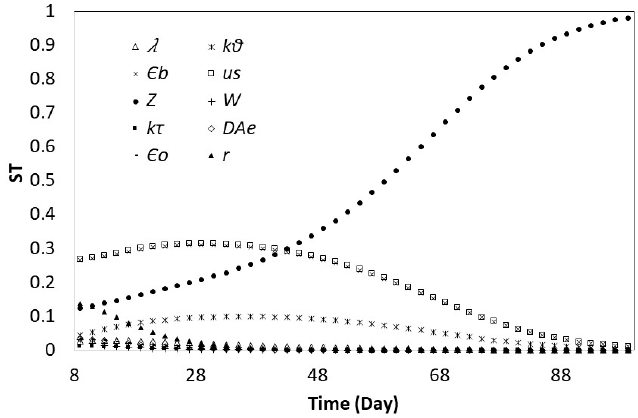
Figure 4. GSA of the model with a heap height equal to 300 cm.